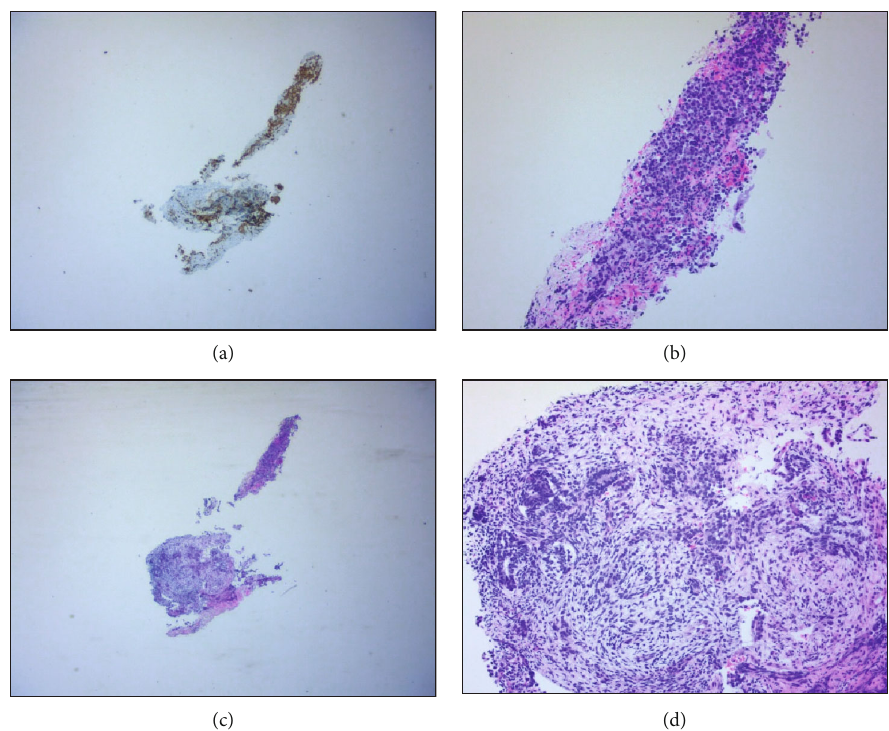
Figure 4: (a) Immunohistochemical stain of SALL-4, a marker for germ cell tumor. (b) Seminoma portion, 100x. (c) H&E of the whole biopsy. (d) Yolk sac carcinoma, 100x. Note the glands with atypical cells forming glandular architecture and solid area, which are all positive for Sal-4 and negative for CD30 and GFAP (glial fi brillary acidic protein). The atypical glands are positive for pancytokeratin and glypican-3, and the solid area is positive for OCT3/4 and CK117. These fi ndings supported a diagnosis of mixed germ cell tumor with yolk sac